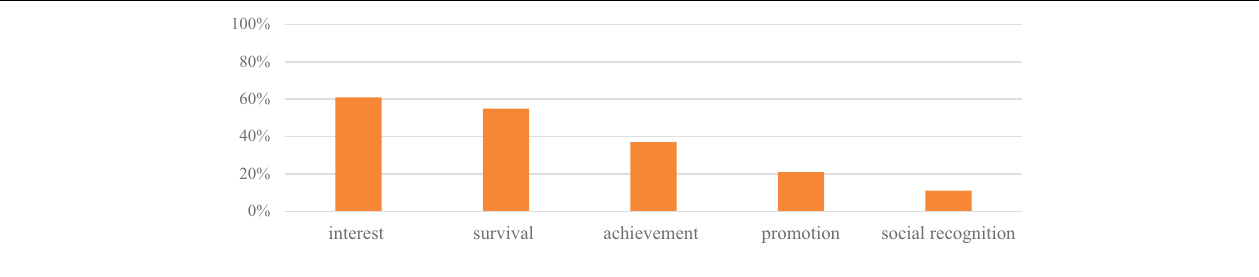
FIGURE 1 | Meanings derived from teaching before taking